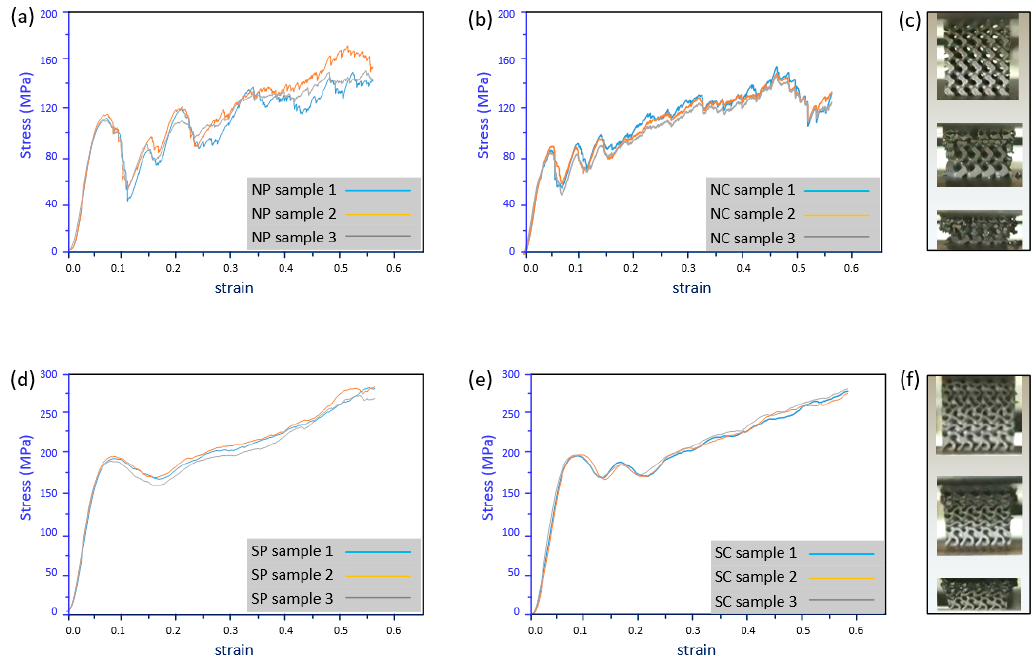
Figure 6. Stress–strain curves of ( a ) NP, ( b ) NC, ( d ) SP, and ( e ) SC and deformation response of ( c ) network-based and ( f ) sheet-based structures in compressive tests.